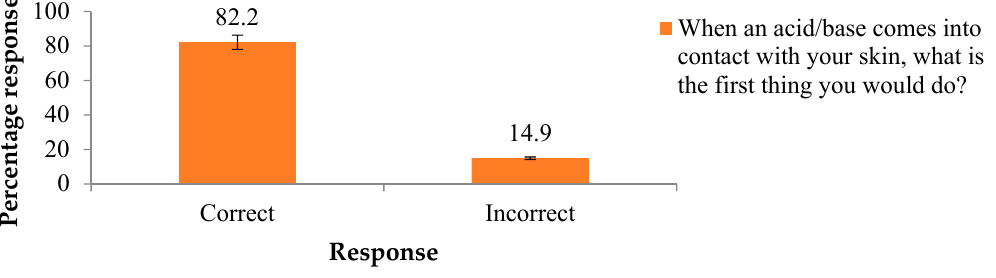
Figure 9. Percentage distribution of students’ response for the questions on Emergency Equipment and Procedures (Question 31).